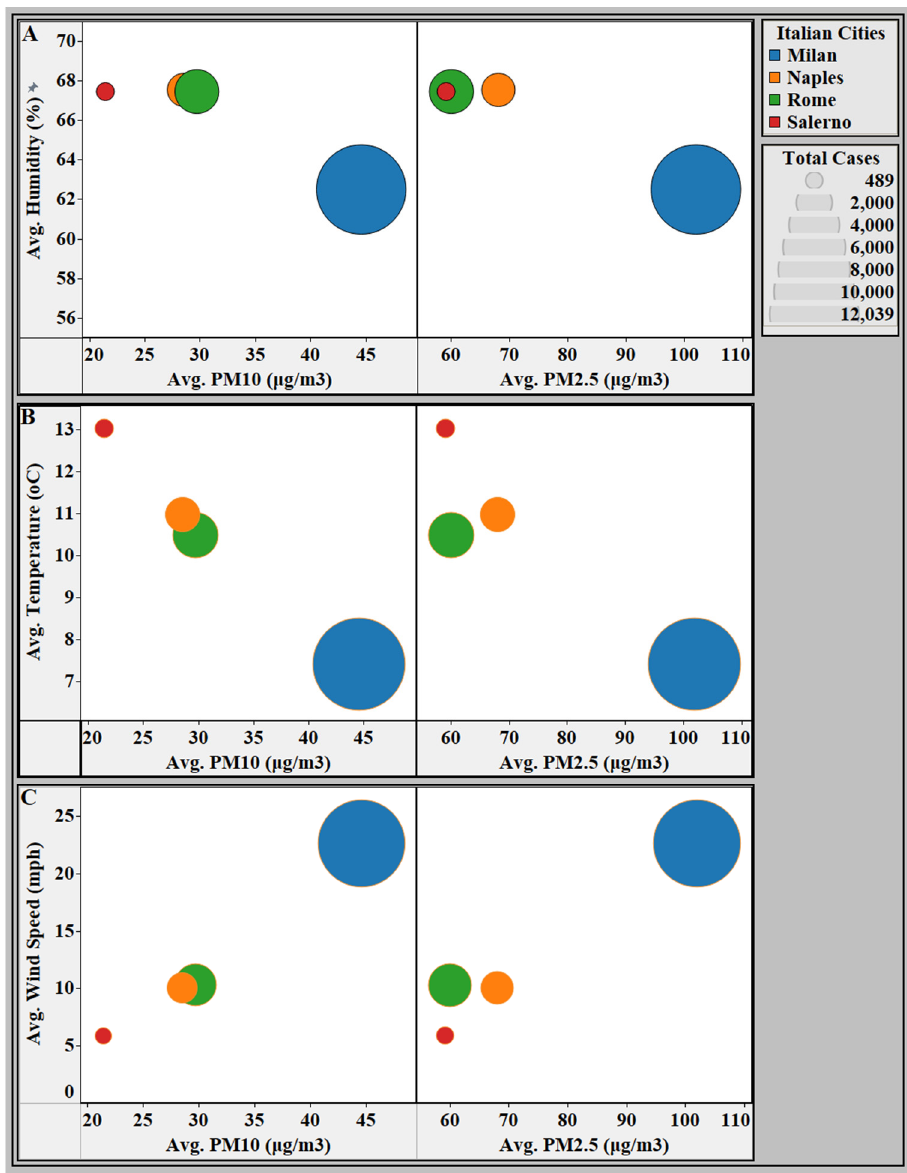
Figure 3. Comparison analysis between the average PM 10 or PM 2.5 concentrations and climatological conditions applied to the average number of confirmed new cases of COVID-19 by city (Janu-